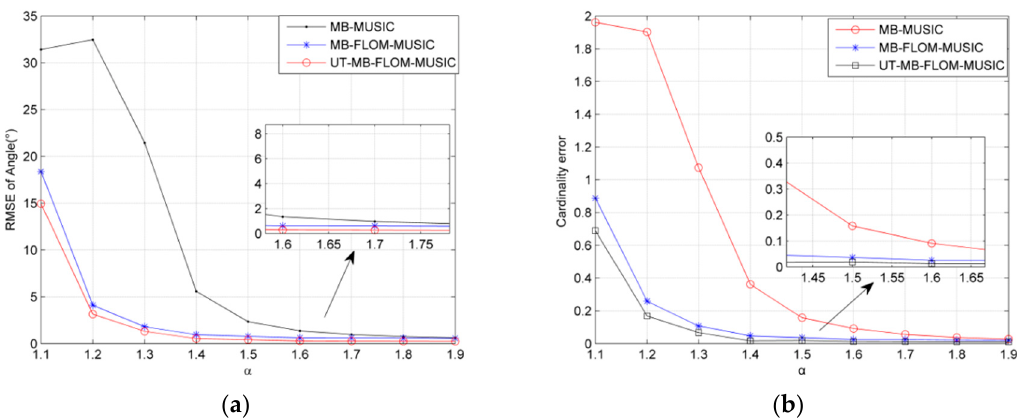
( b ) Figure 3. RMSE of angle under α = 2, L = 100 and GSNR = 10 dB: ( a ) The RMSE of 100 MC; ( b ) source trajectory of Single MC. Since Gaussian noise does not reflect true signal interference, the α stable distribution can reflect the impact of impulse noise. Figure 4 shows the RMSE and cardinality estimation error plots for three algorithms running 100 MC when the characteristic index α is different and the GSNR = 10 dB, L = 100. It can be seen from Figure 4a that, in α= 1.1~ 1.9 , the RMSE error of the three estimation algorithms first decreases, and finally tends to be flat. It also can be seen that the RMSE of the UT- MB-FLOM-MUSIC algorithm is significantly smaller than the MB-FLOM-MUSIC and MB-MUSIC algorithms when α = 1.1 or α = 1.2, so that the UT-MB-FLOM-MUSIC algorithm has a better effect